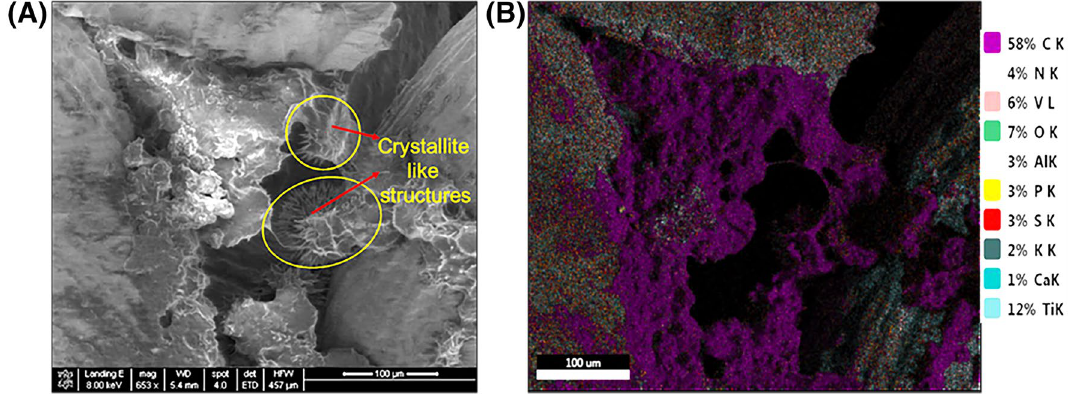
Figure 6. SEM (Left) and EDX (Right) image of wire mesh scaffold in contact with the bone pulled out from bioreactor at week 7 at 653× magnification. SEM image showing the presence of crystallite like structures and EDX showing the presence of elements present on the matrix at the same location shown in the SEM